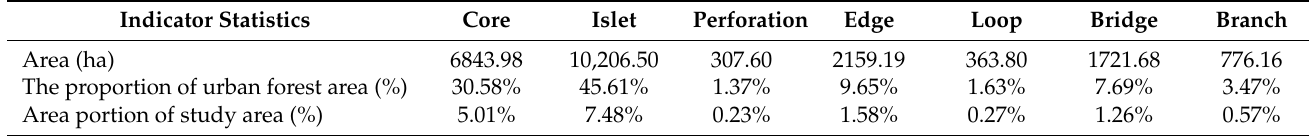
Table 4. The area and proportion of landscape types based on